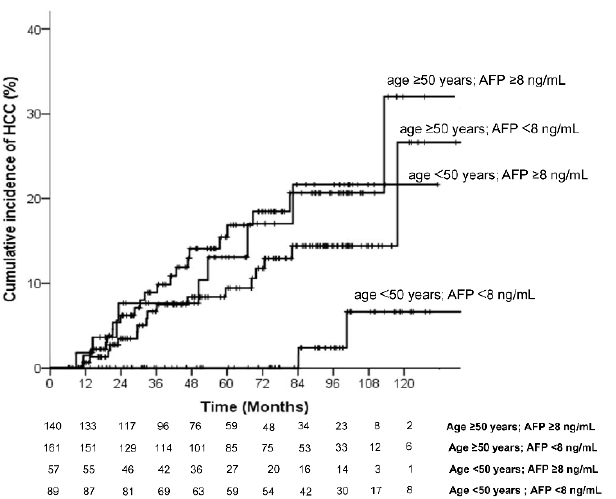
Figure 2. Cumulative incidence of hepatocellular carcinoma according to age and AFP .